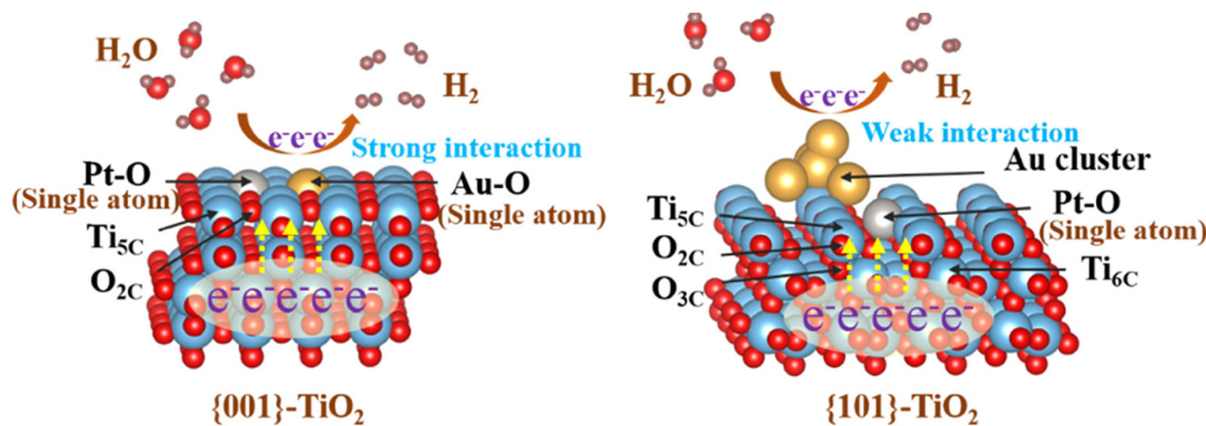
Figure 7. Schematic illustration of charge transfer in dual-site co-catalyzed {001} and {101}-faceted TiO 2 . Blue, red, gray, yellow, and brown spheres represent Ti, O, Pt, Au, and H atoms, respectively. With permission from Ref [94], Copyright © 2021 American Chemical Society.